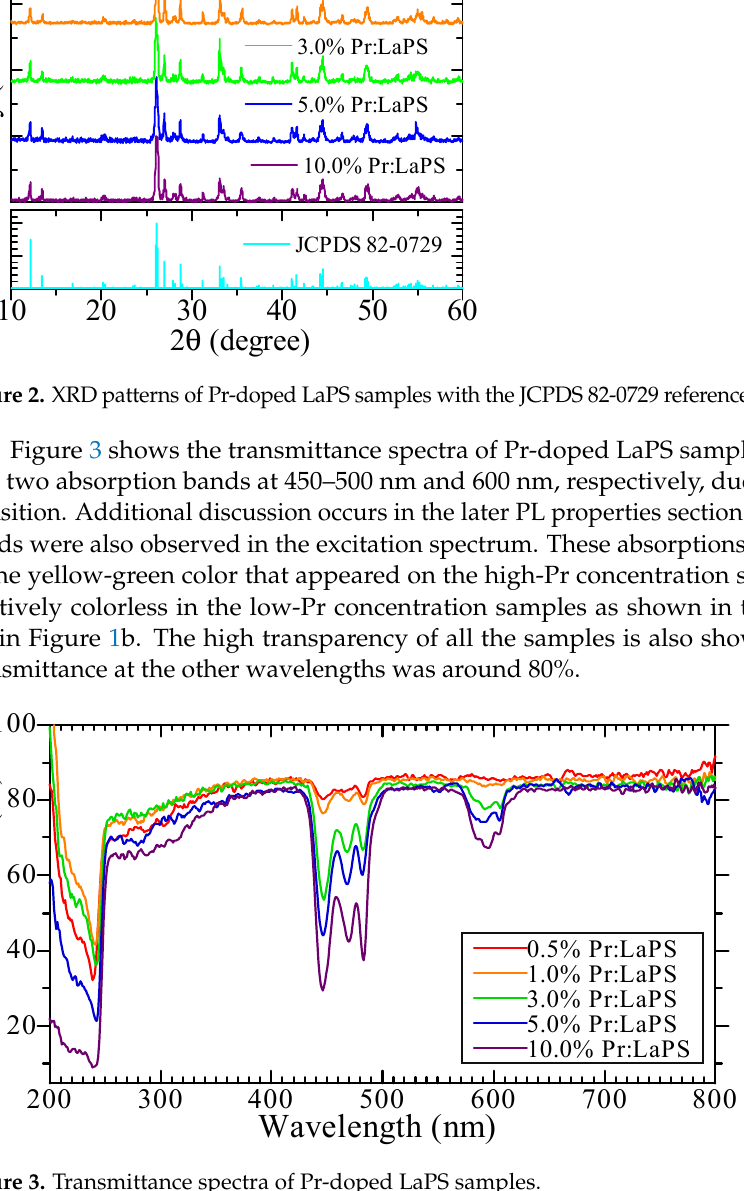
Figure 3. Transmittance spectra of Pr-doped LaPS samples.